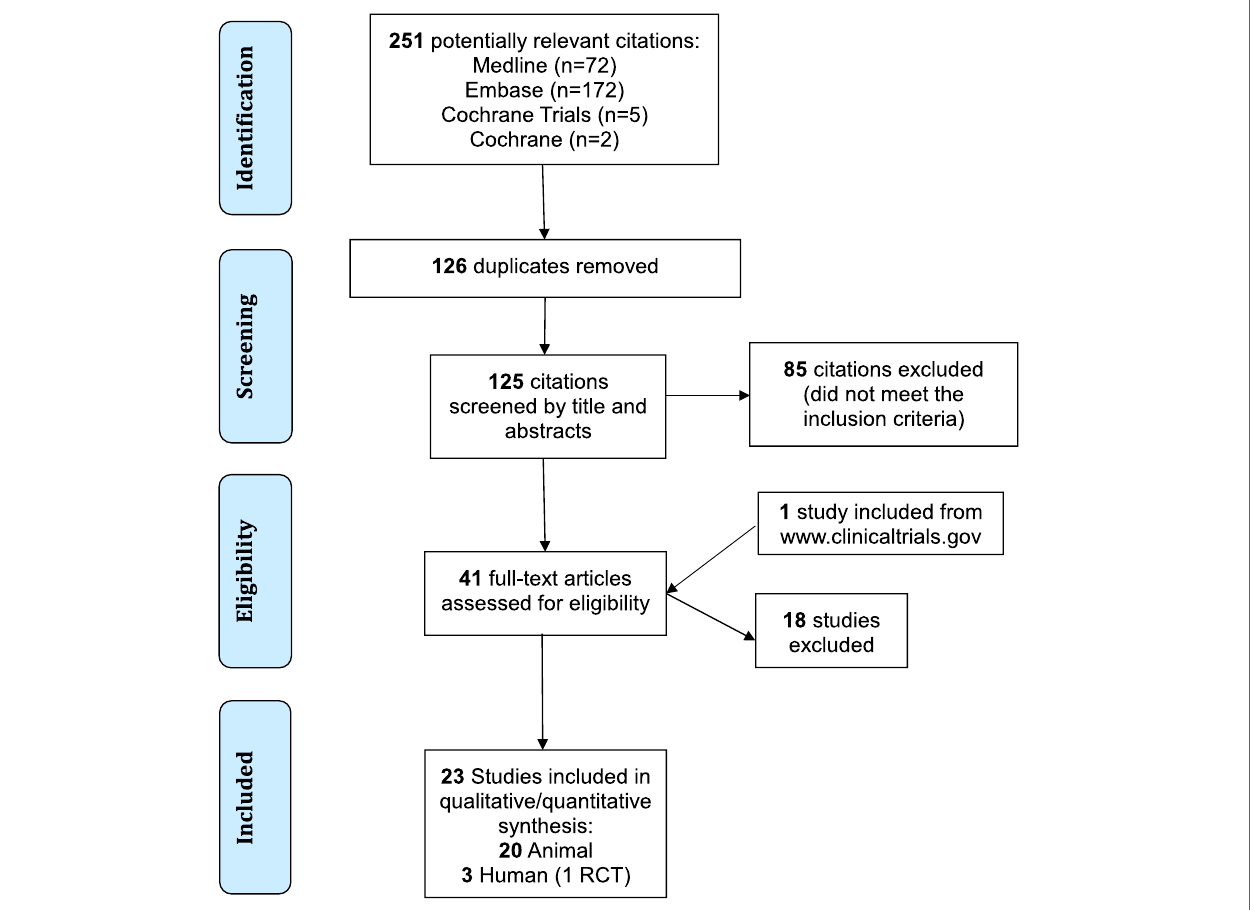
FigURe 1 | Flow diagram of the screening process. RCT, randomized controlled trial; TBI, traumatic brain